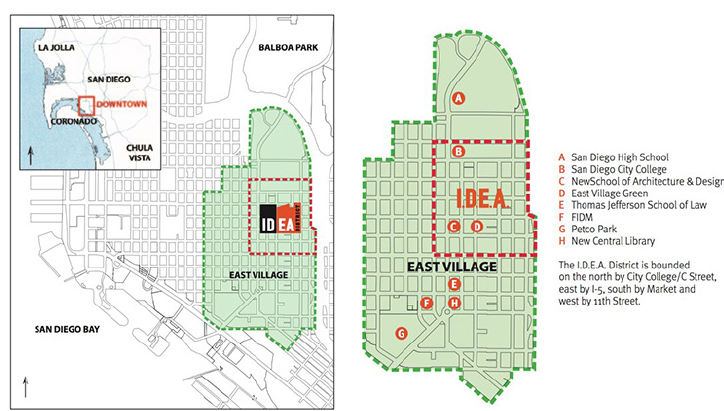
Figure 3. I.D.E.A. District location within San Diego’s East Village (I.D.E.A. District,